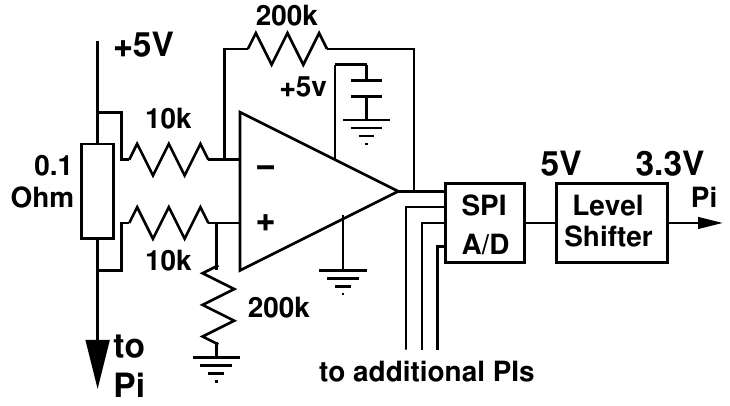
Figure 5. The circuit used to measure power. An op-amp provides a gain of 20 to the voltage drop across a sense resistor. This can be used to calculate current and then power. The values from four Pis are fed to a measurement node using an SPI A/D converter. The 5-V SPI bus is converted down to the 3.3 V expected by the Pi measurement